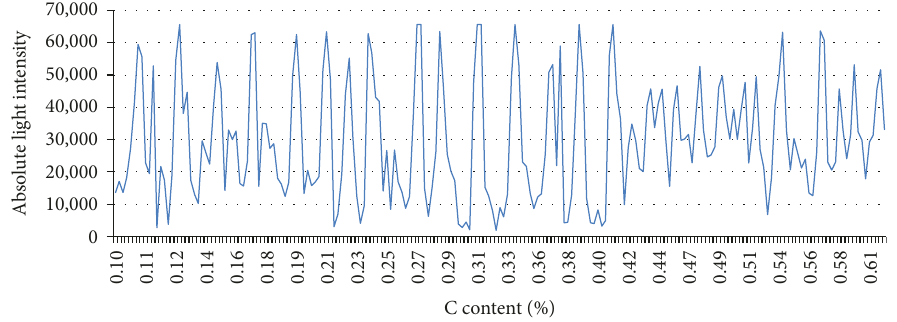
Figure 7: The signal diagram of the converter 6C00582 with absolute intensity as the original signal.